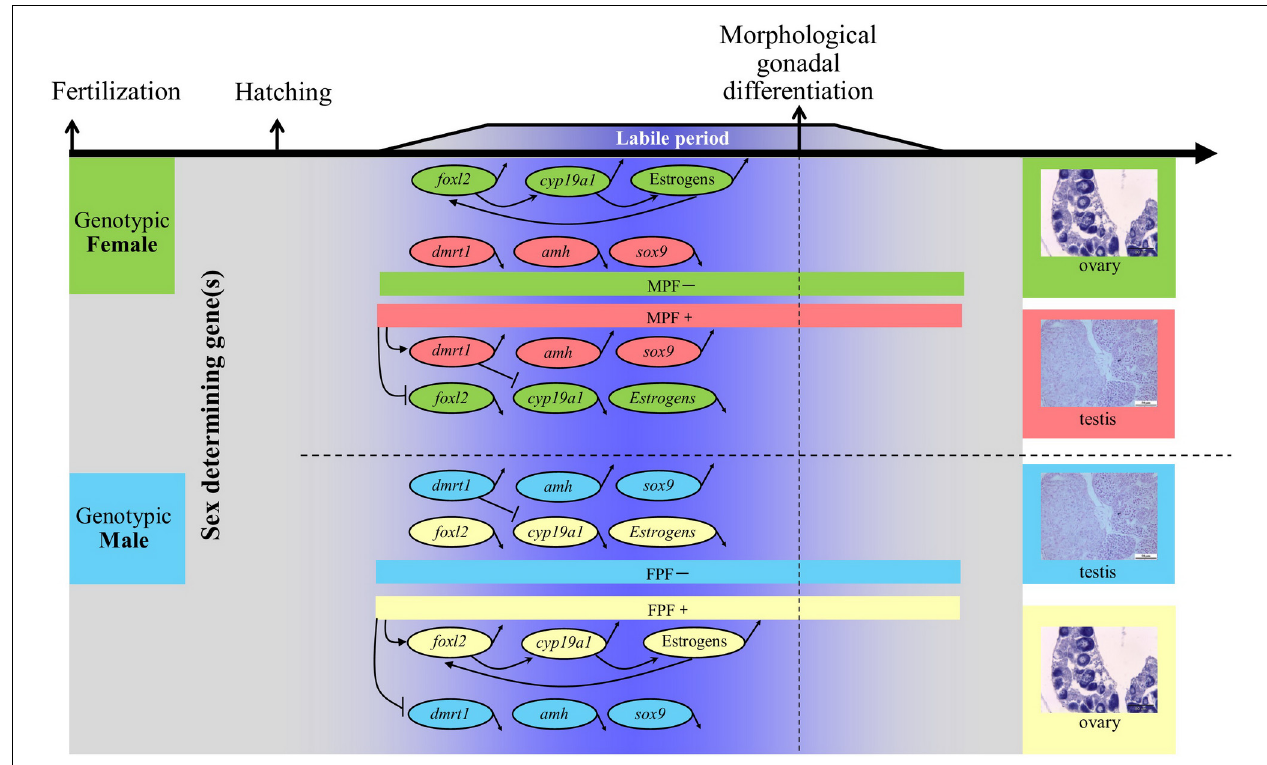
FIGURE 1 | General schematic diagram of molecular players involved in sex differentiation of gonochoristic teleost with genetic sex determination. Note that this represents a “typical” sex-differentiation pathway, while large-scale variations exist with respect to timing and sexual dimorphism of expression, as well as regulatory mechanisms. MPF, male producing/promoting factors, including androgens, estrogen receptor antagonists, aromatase inhibitors, male producing temperature, etc. FPF, female producing/promoting factors, including estrogens, androgen receptor antagonists, female producing temperature, etc. Upward/downward arrows indicate the expression of specific gene is upregulated/downregulated, respectively. Arrows pointing to specific gene indicate that the expression is upregulated. Inhibiting symbols pointing to specific gene indicate that the expression is downregulated. Data refer to D’Cotta et al. (2007); Vizziano et al. (2007); Wang et al.